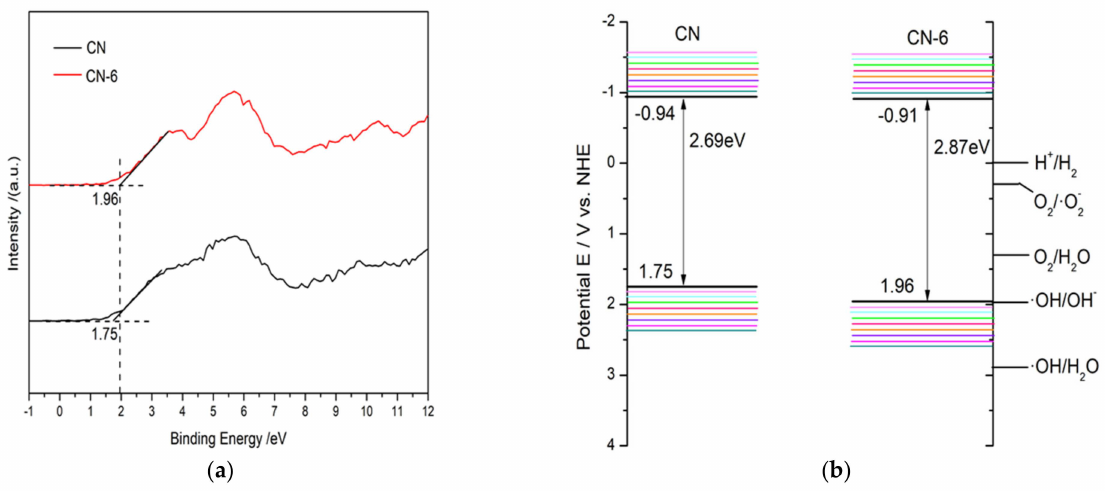
Figure 11. ( a ) The valence band X-ray photoelectron spectroscopy of CN and CN-6, and ( b ) band structures of CN and CN-6.